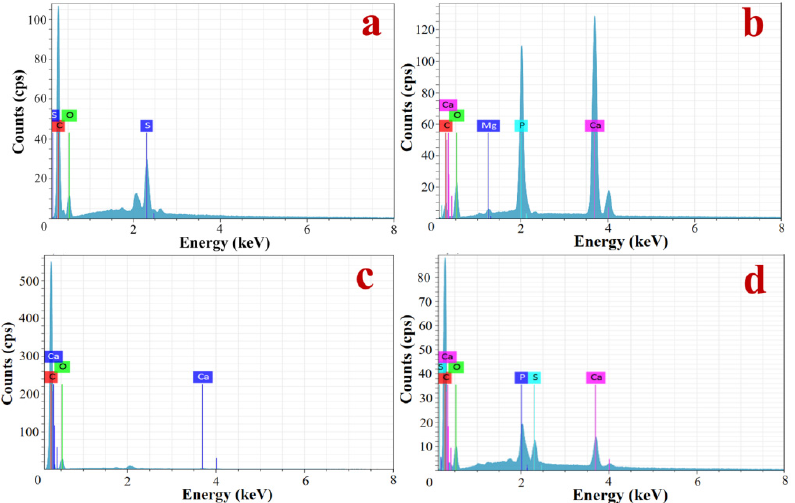
Figure 2. Element detection diagram of the turtle carapace. ( a ) Cuticle layer. ( b ) Bone layer. ( c ) Con- nection area. ( d ) The junction between the keratin scutes and the bone. nection area. ( d ) The junction between the keratin scutes and the